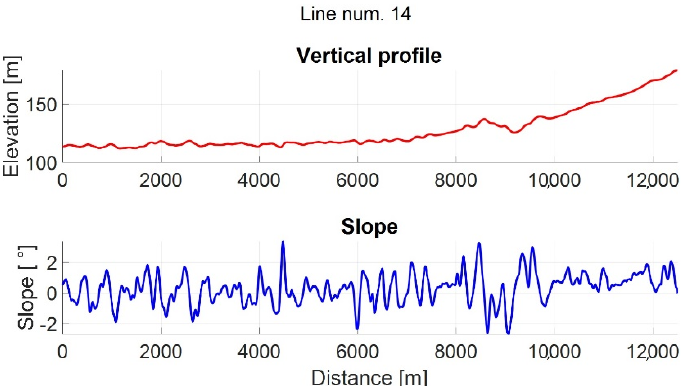
Figure 12. Track elevation profile and slope of line No. 14.